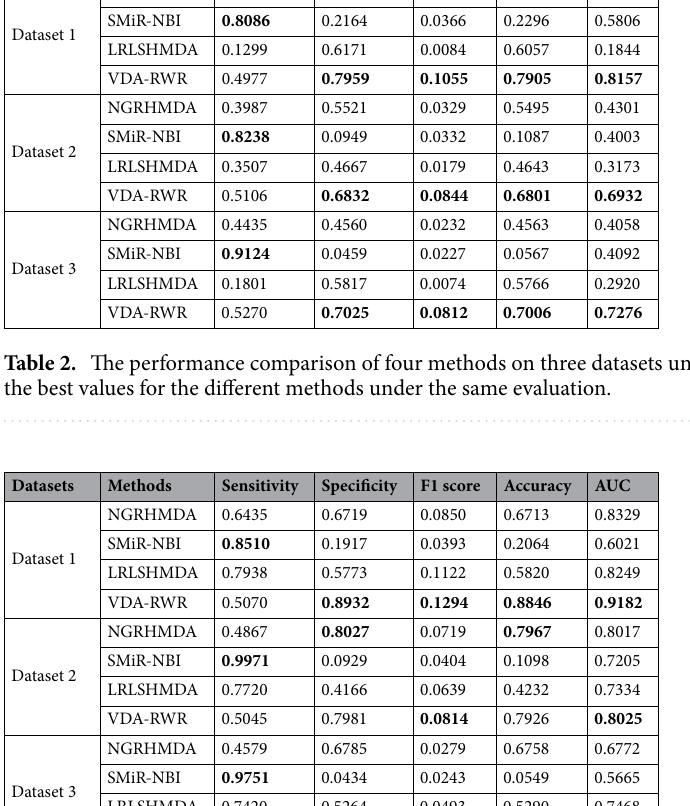
Table 3. The performance comparison of four methods on three datasets under CV2. Bold values indicates the best values for the different methods under the same evaluation.